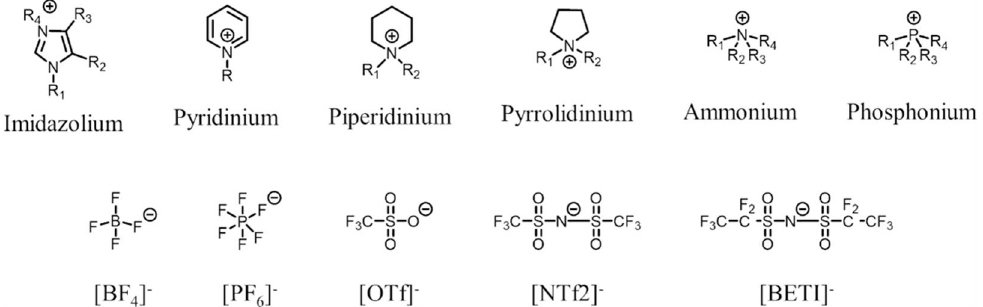
Figure 7. Cations and anions commonly employed in ILs synthesis.